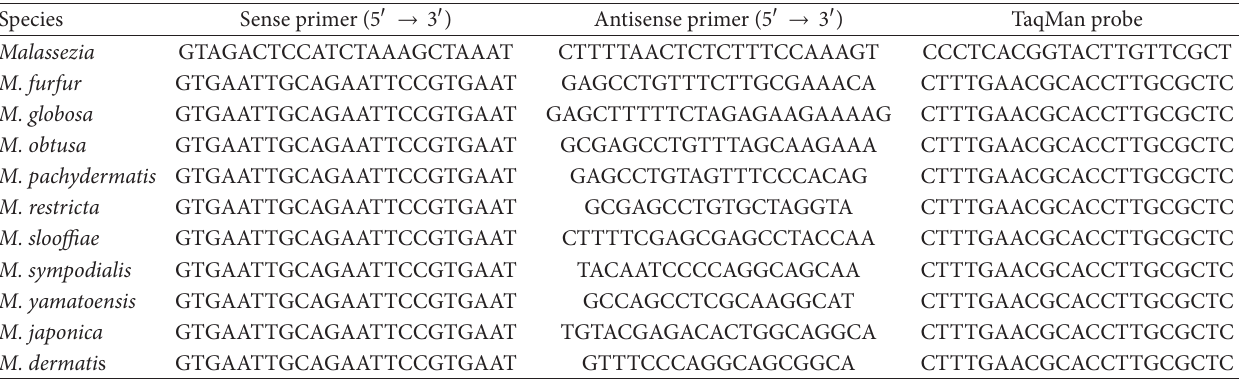
Table 2: Primers and probes used in RT-PCR.